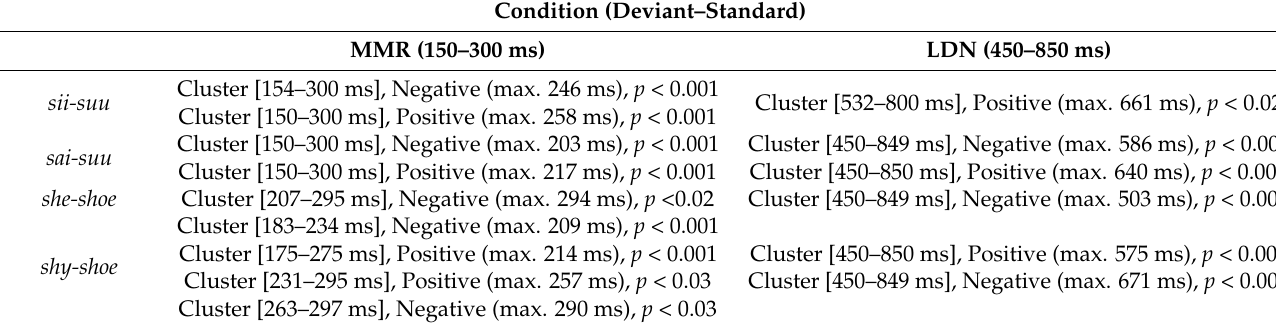
Table 3. Summary of the within CTR group statistics using cluster-based permutation tests for the native (Finnish) and foreign (English)